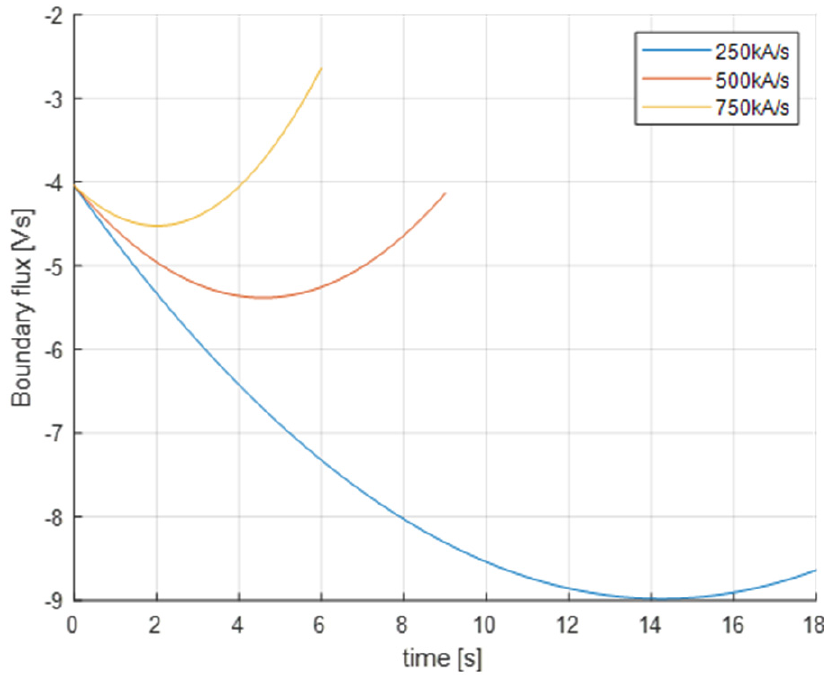
Figure 7. Boundary flux evolution for different plasma current ramp rates according to Formula (2). After the H–L transition, the plasma volume gradually reduces while β p is kept constant to 0.1 and l i linearly increases. Plasma shape evolves from an elliptical shape to a circular one, and in the time interval between t = 97 and t = 101 s, the divertor to limiter transition occurs. After t = 103 s, the plasma discharge is terminated. For future development, the possibility to delay the divertor–limiter transition is under analysis. In Figures 8 and 9, the time evolution of plasma shapes and CS/PF voltages during the ramp- down phase are reported, respectively, while in Tables 7 and 8, the behavior of currents and plasma parameters are